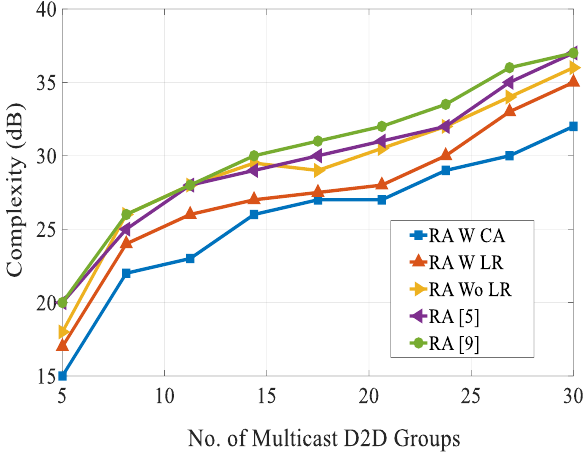
Figure 8. Complexity vs. no. of multicast D2D groups.